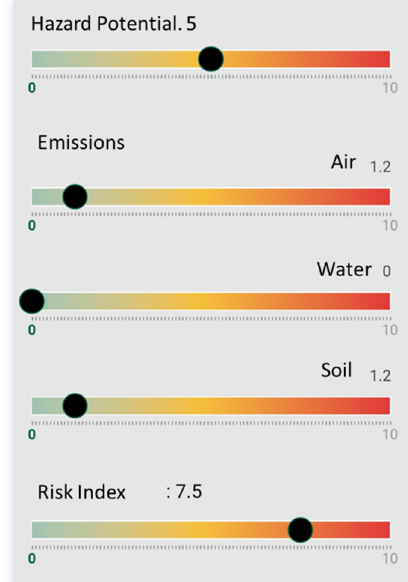
Figure 8. Excerpt from the report generated with the NanoSerpa v1.0 app for the release of TiO 2 nanopowder from a bag filter system. These results apply only to the exposure area where the events studied have occurred.